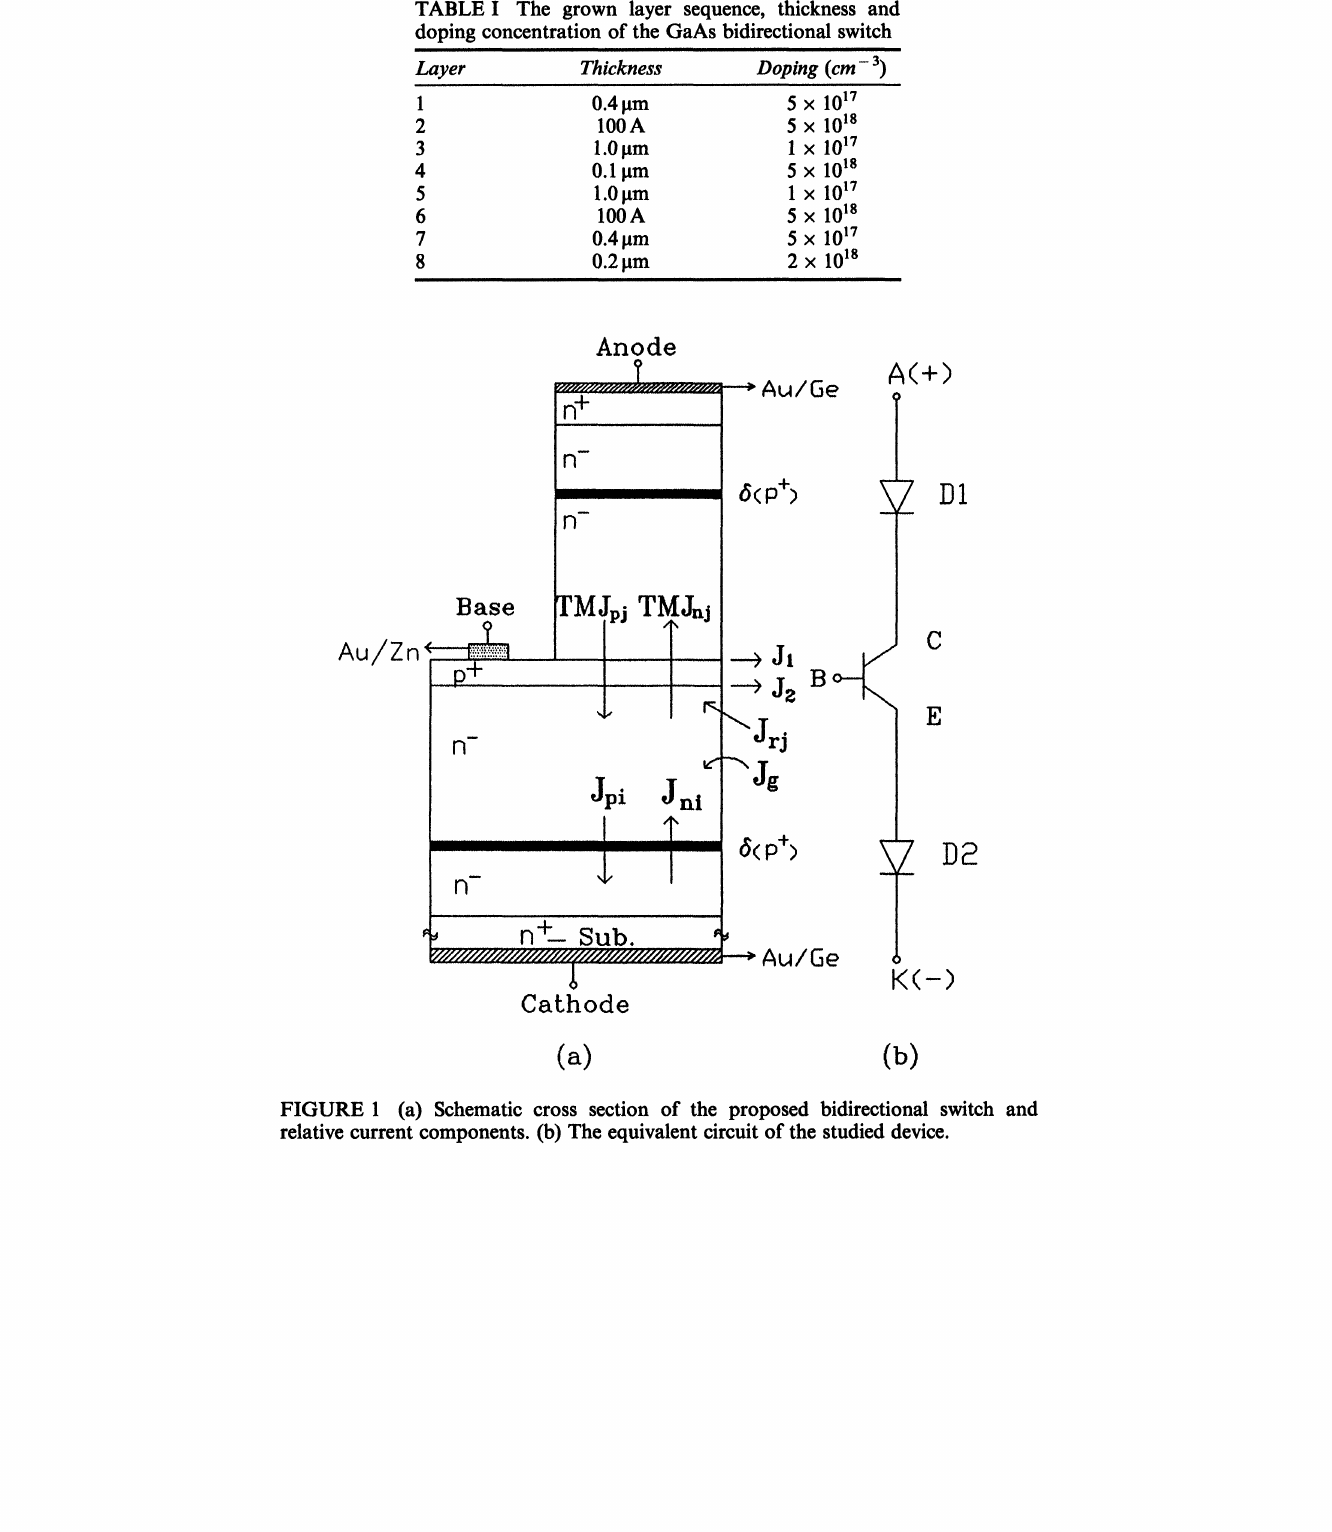
The grown layer sequence, thickness and doping concentration of the GaAs bidirectional switch